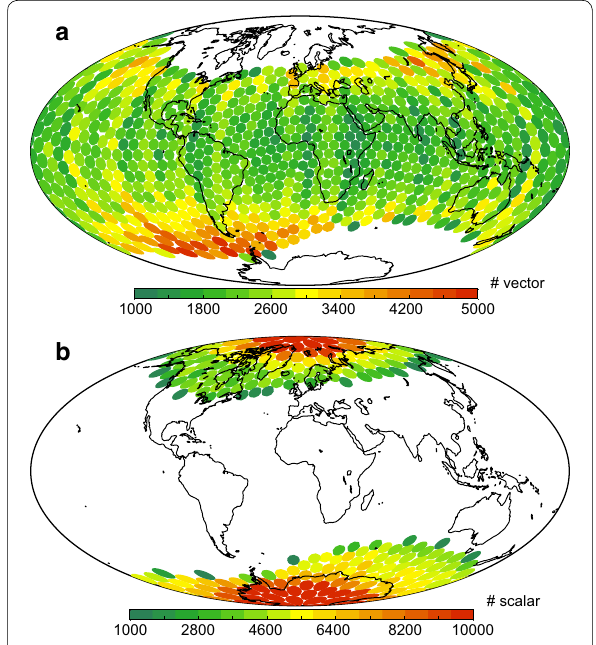
Fig. 3 a Total number of vector Swarm A data within the spherical caps of 3.3° semi‑angle for the period 1st July 2014 to 30th June 2015. b Same for the scalar Swarm